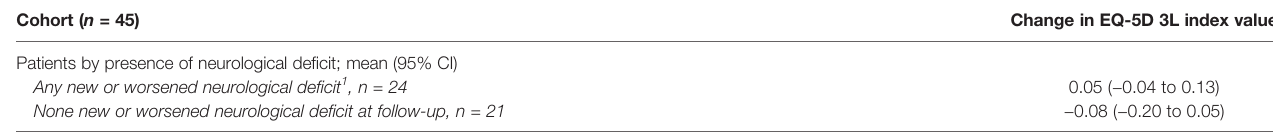
TABLE 6 | Change in the EQ-5D 3L index value in patients grouped by presence of neurological de fi cit at follow-up ( N = 45). Cohort ( n = 45) Change in EQ-5D 3L index value